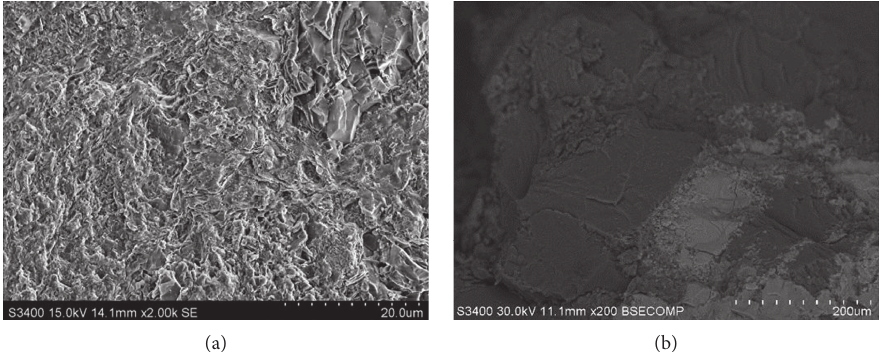
Figure 13: Microscopic image of sandstone in its natural state: (a) SEM image of specimens and (b) BSE image of